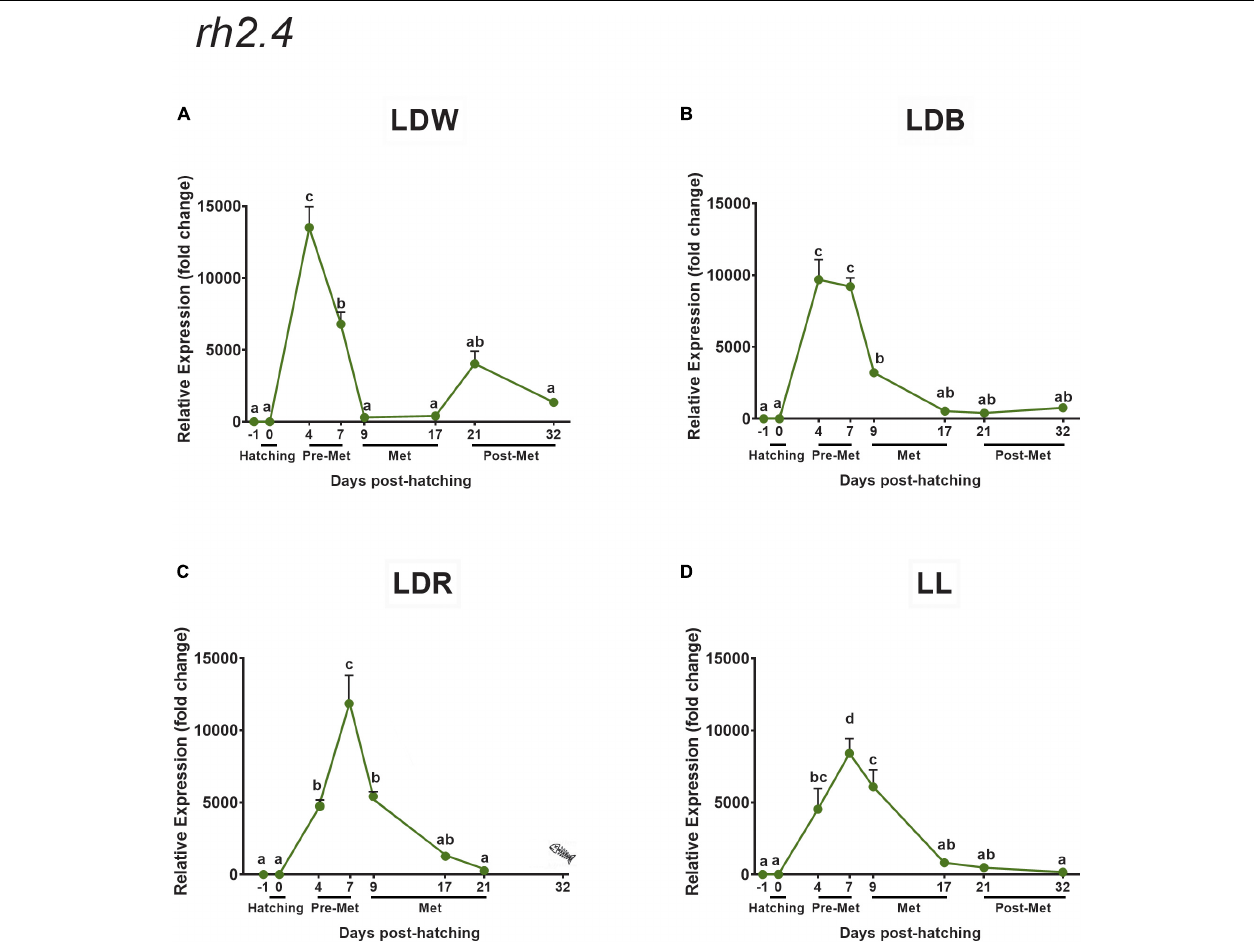
FIGURE 8 | Expression of green cone opsin ( rh2.4 ) in embryos, larvae, and juveniles of the Senegalese sole on dph –1 (embryos), dph 0 (hatching), dph 4–7 (pre-metamorphosis, Pre-Met), dph 9–17 (metamorphosis, Met), and dph 21–32 (post-metamorphosis, Post-Met) analysed by RT-qPCR. For further information, see the legend in Figure 1